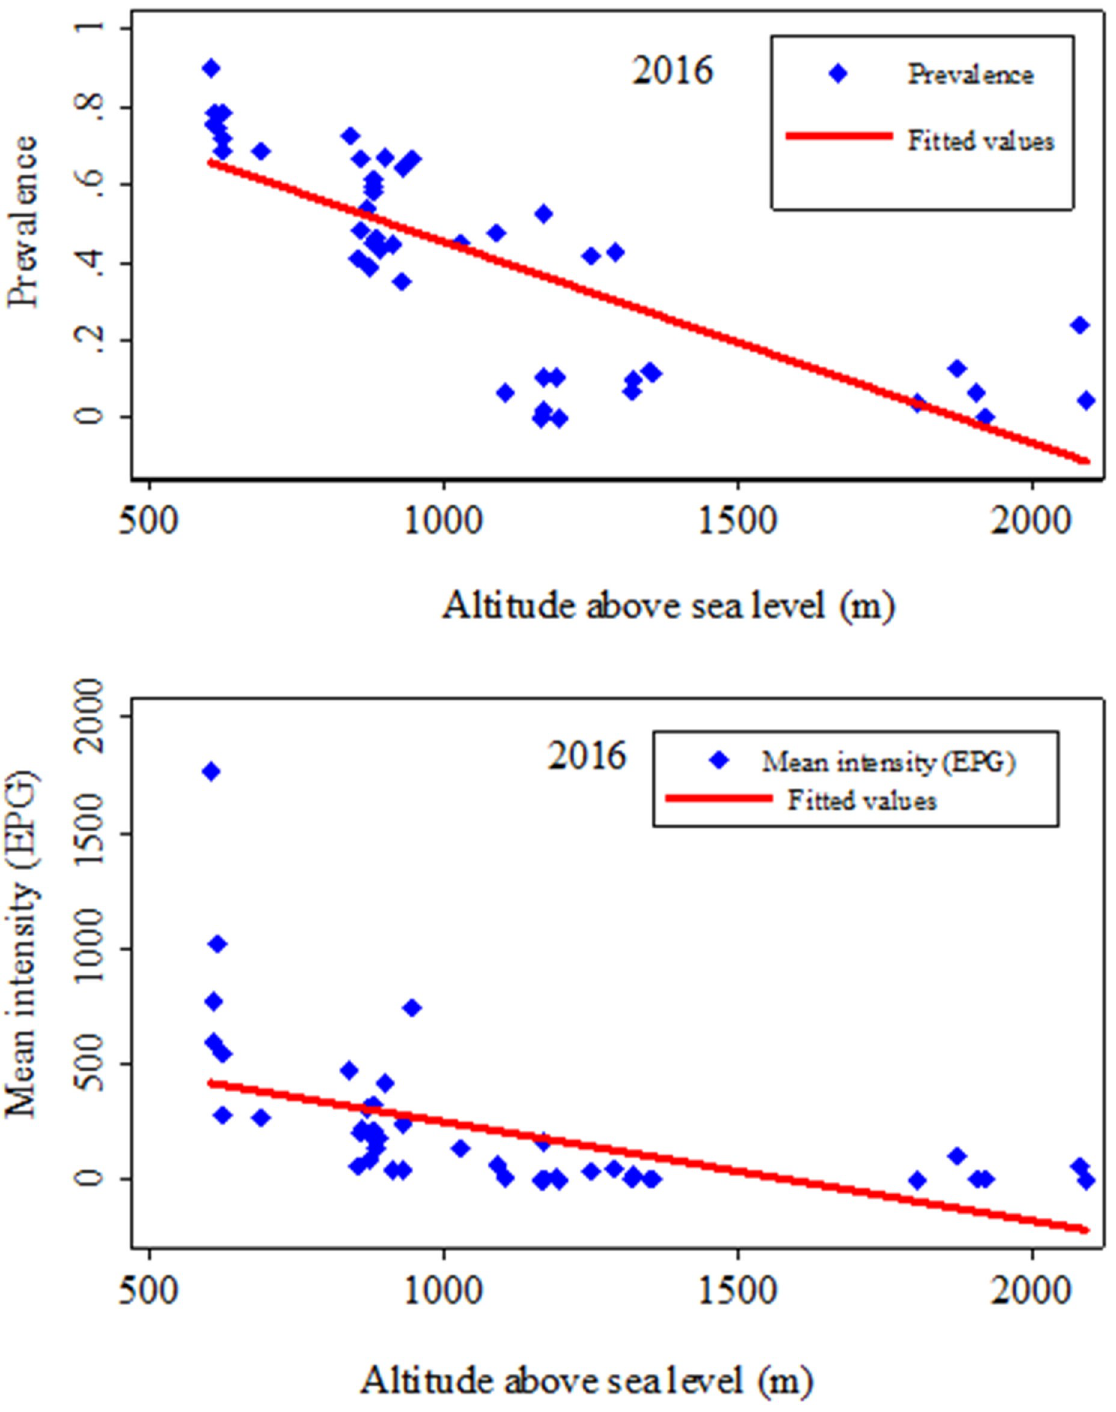
Fig 8. Correlation of S . mansoni infection prevalence and intensity with altitude (meters above sea level) in the 2016 distribution study. The figure above shows the influence of altitude on S . mansoni infection prevalence (top) and intensity expressed as an arithmetic mean (bottom) as observed in 2016. The higher the altitude, the lower the infection prevalence and intensity.